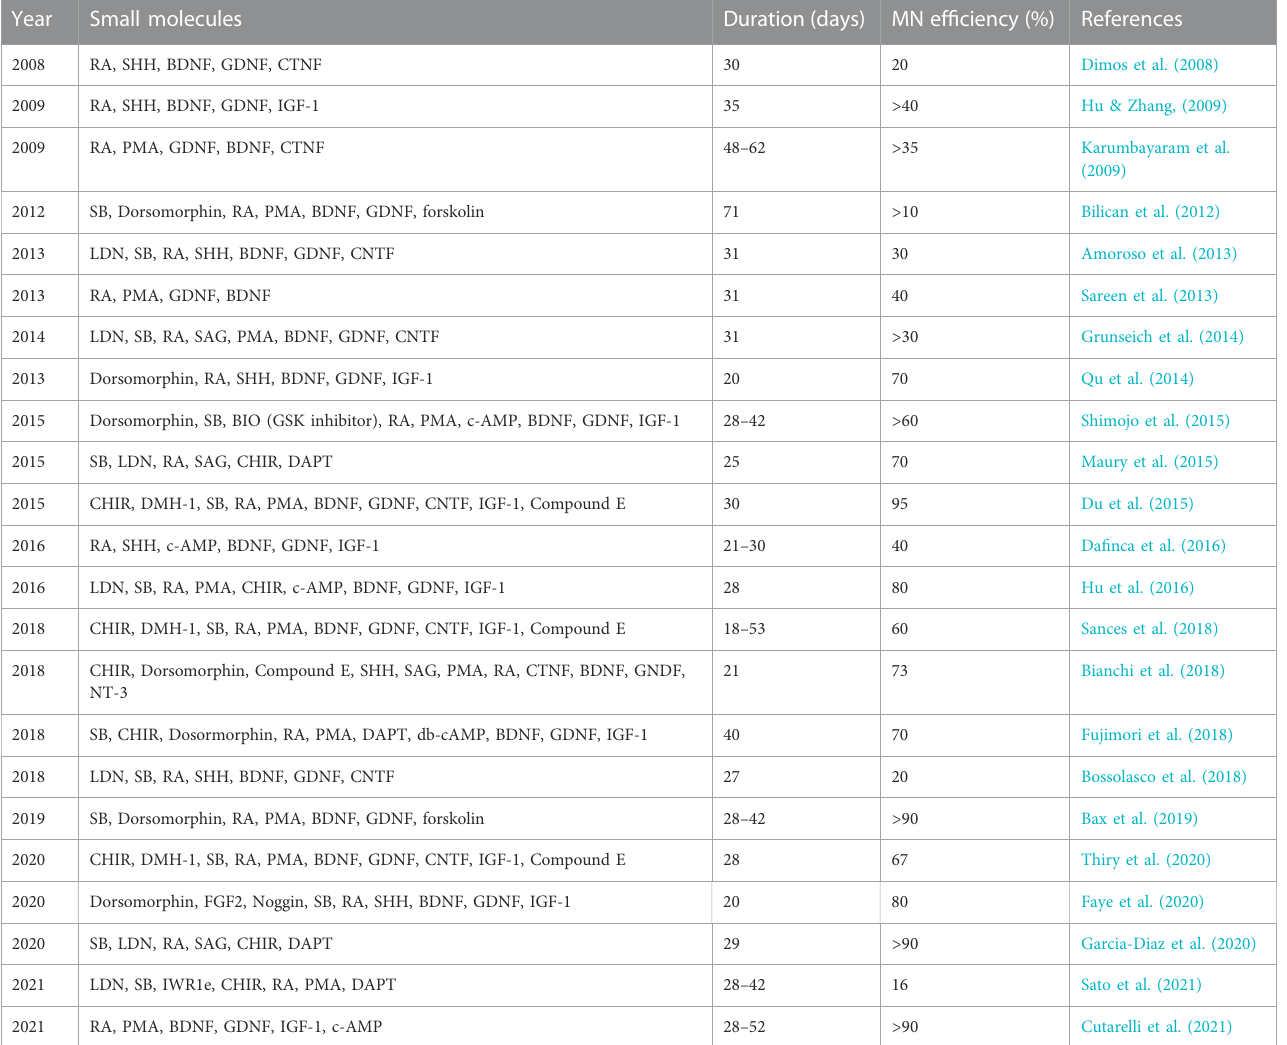
TABLE 1 Protocols using small molecules to direct the differentiation of human iPSCs into